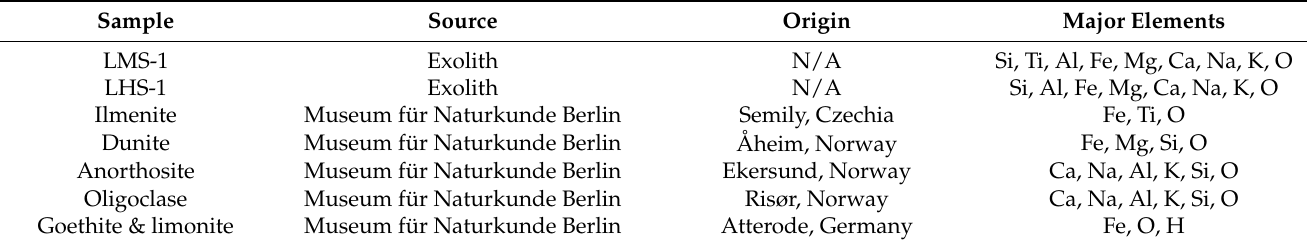
Table 2. Geological samples used in the lunar analogue